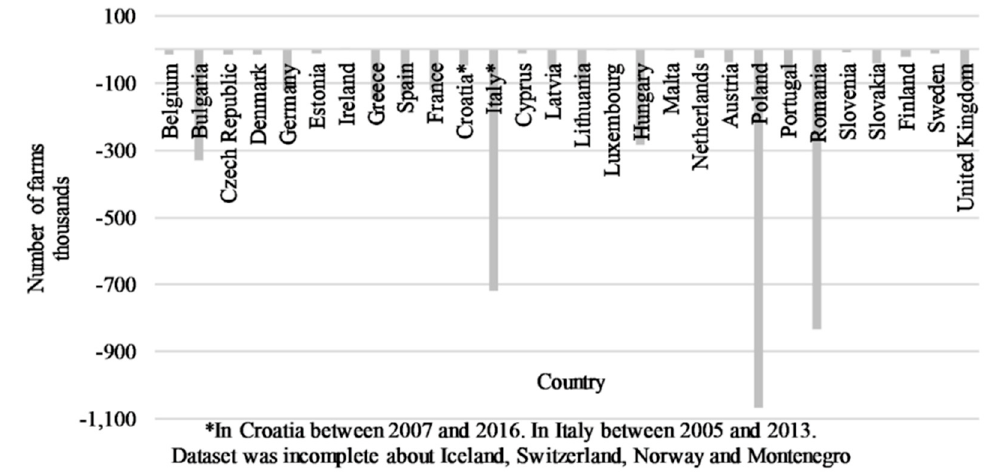
Figure 3. Change in the number of farms in Europe between 2005 and 2016 (Eurostat).